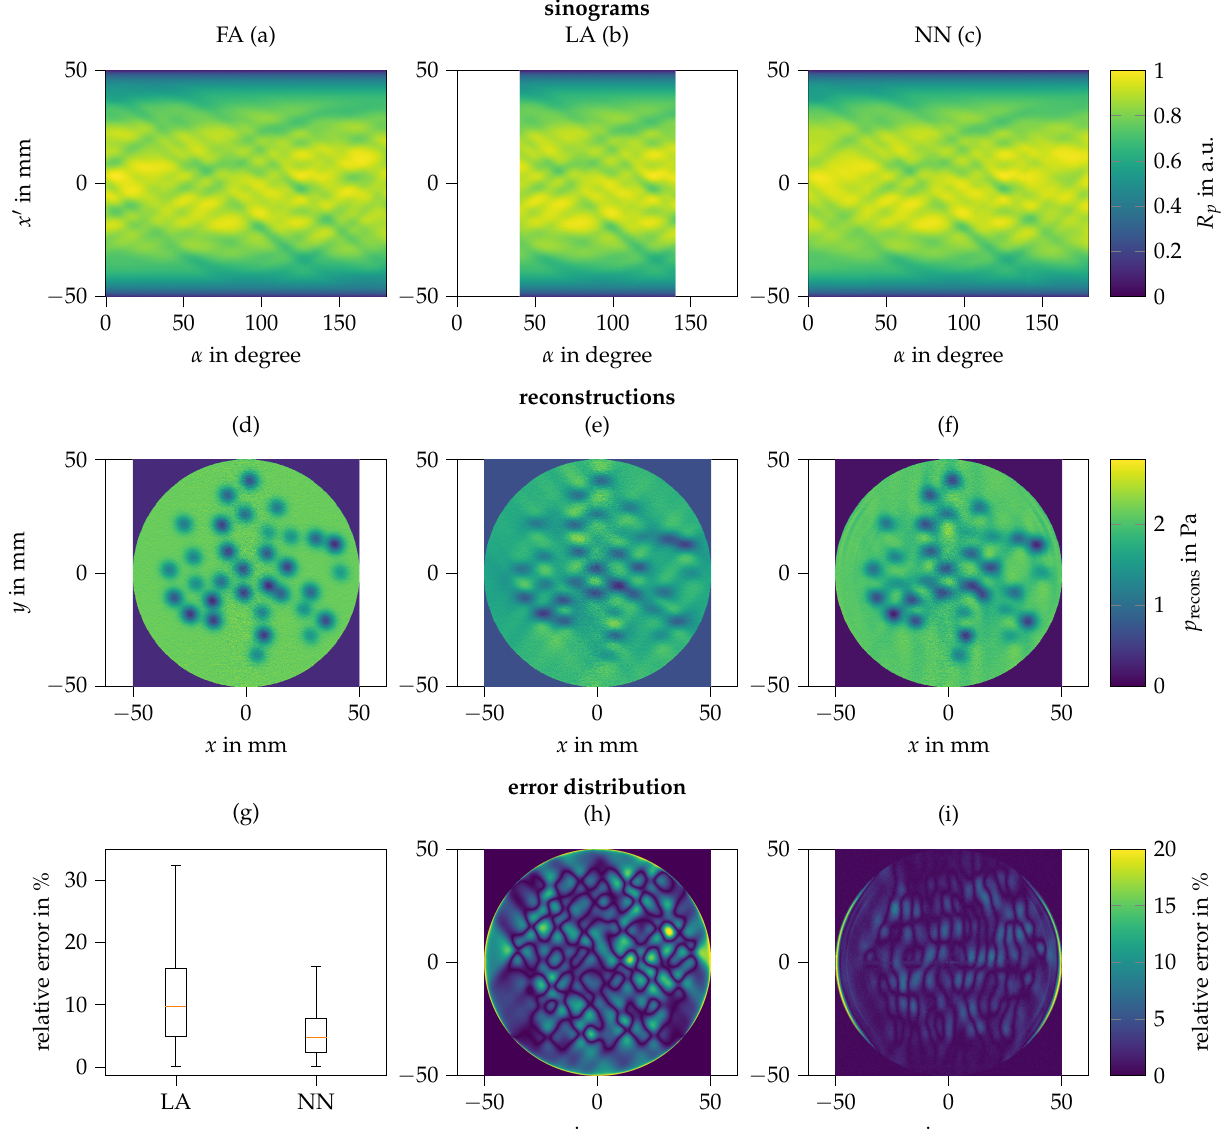
Figure 9. Synthetic sound pressure field reconstruction: ( a ) full angle (FA) sinogram; ( b ) limited angle (LA) sinogram; ( c ) neural network (NN) extrapolated sinogram; ( d ) full angle filtered back projection tomographic reconstruction; ( e ) lim- ited angle filtered back projection tomographic reconstruction; ( f ) neural network extrapolated filtered back projection tomographic reconstruction; ( g ) error distribution of local reconstructions compared to full angle reconstruction; ( h ) local error of limited angle reconstruction compared to full angle reconstruction; ( i ) local error of neural network reconstruction compared to full angle